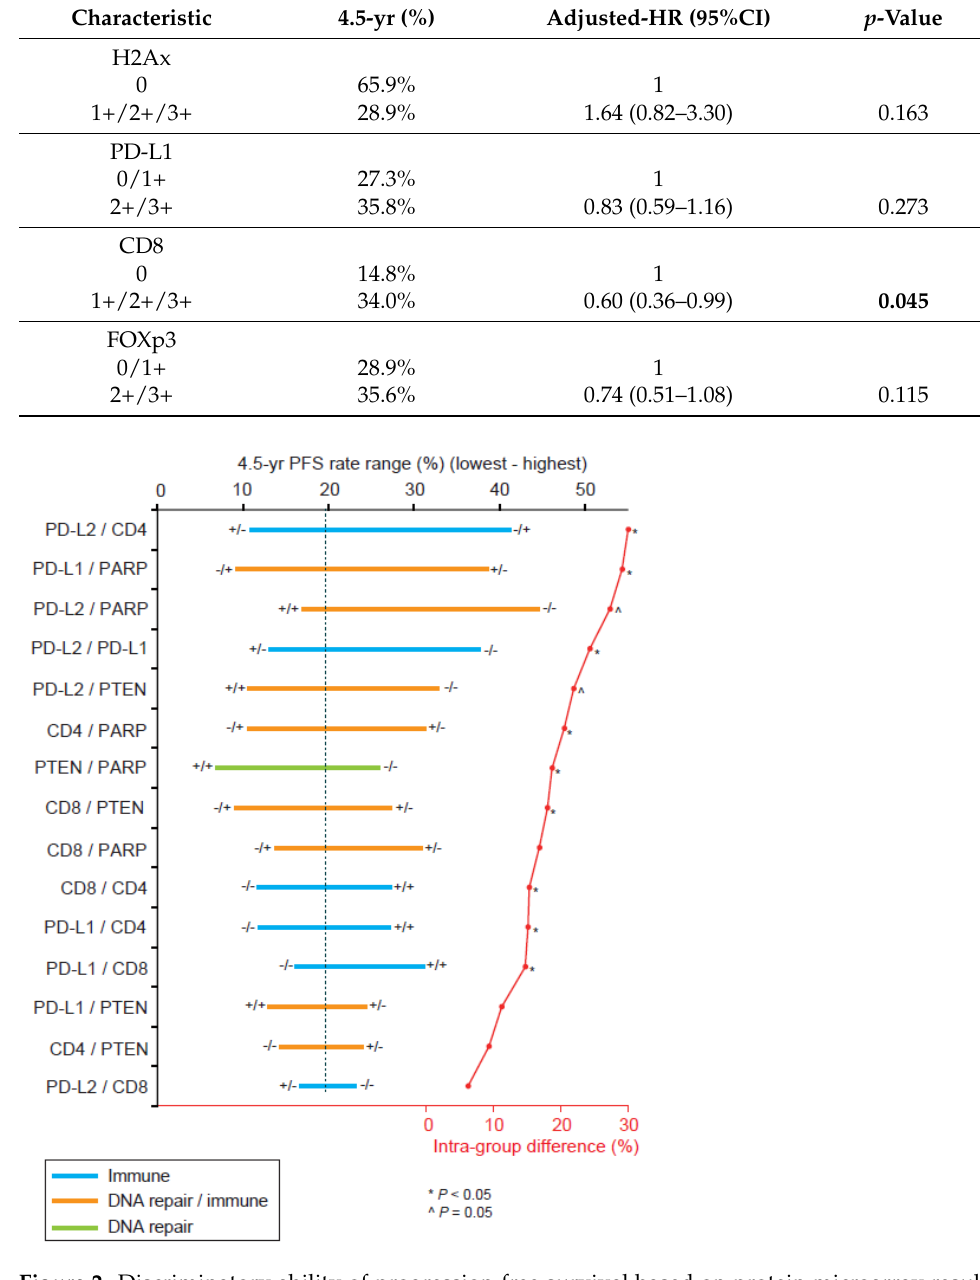
Figure 2. Discriminatory ability of progression-free survival based on protein microarray results. Among 6 biomarkers identified in multivariate analysis (Table 3), combination patterns of any two biomarkers were assessed (total 15 patterns). In each pattern, biomarker expression was assessed as negative/negative (−/−), negative/positive (−/+), positive/negative (+/−), and positive/positive (+/+). The cutoff definition of negative and positive results is displayed in Table 3. Then, the 4.5-year progression-free survival (PFS) rates were computed, and discriminatory ability defined as the difference between the lowest and highest rates was estimated and shown by red dots and line (displayed as the secondary axis for intra-group difference). A log-rank test was used for p -values (lowest vs. highest). Subgroups with fewer than ten cases were not interpreted for analysis due to insufficient number. Bars represent the highest PFS rate (right side) and the lowest PFS rate (left side) in each biomarker combination. The dashed line indicates the 4.5-year PFS rate of 19.7% for the entire study cohort.